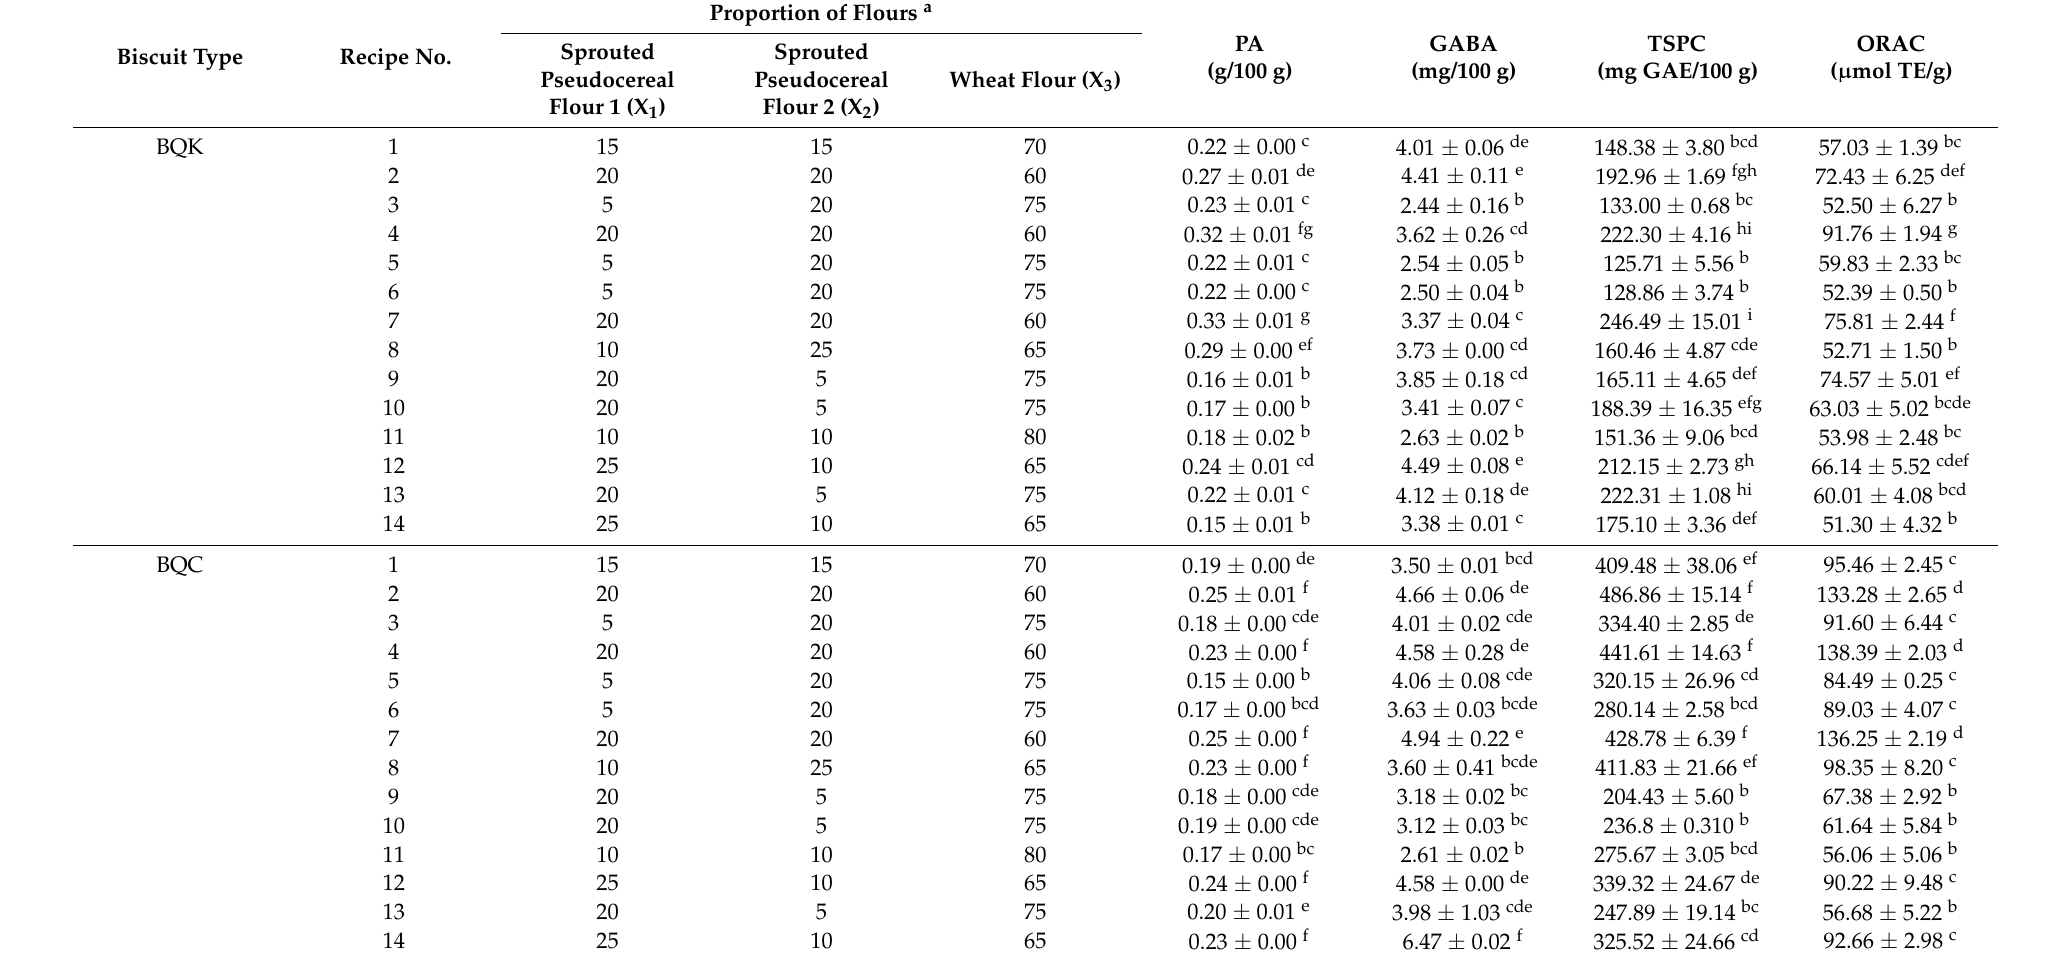
Table 2. Effect of flour formulation on PA, GABA, TSPC, and AA (as determined by ORAC assay) in biscuits.